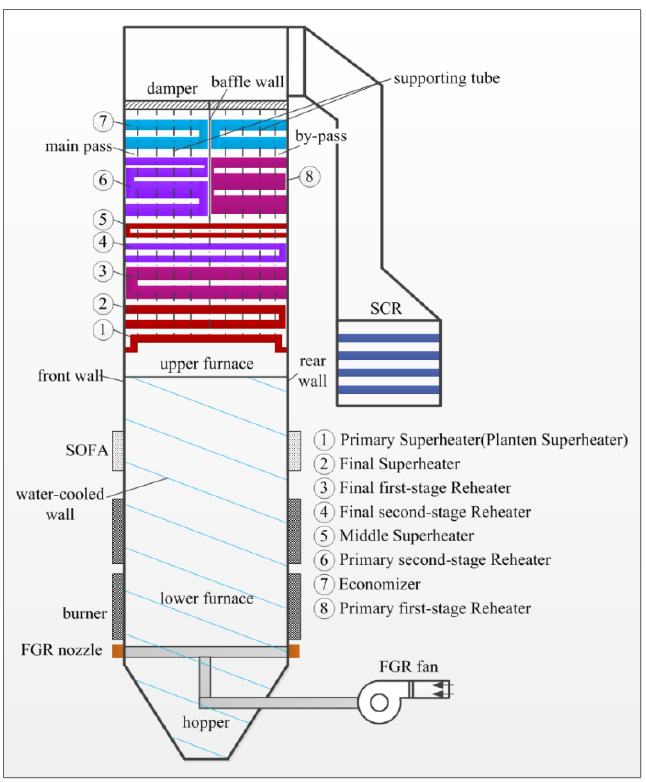
Figure 5. Schematic of the double-reheat tower-type boiler without combined heating surface.